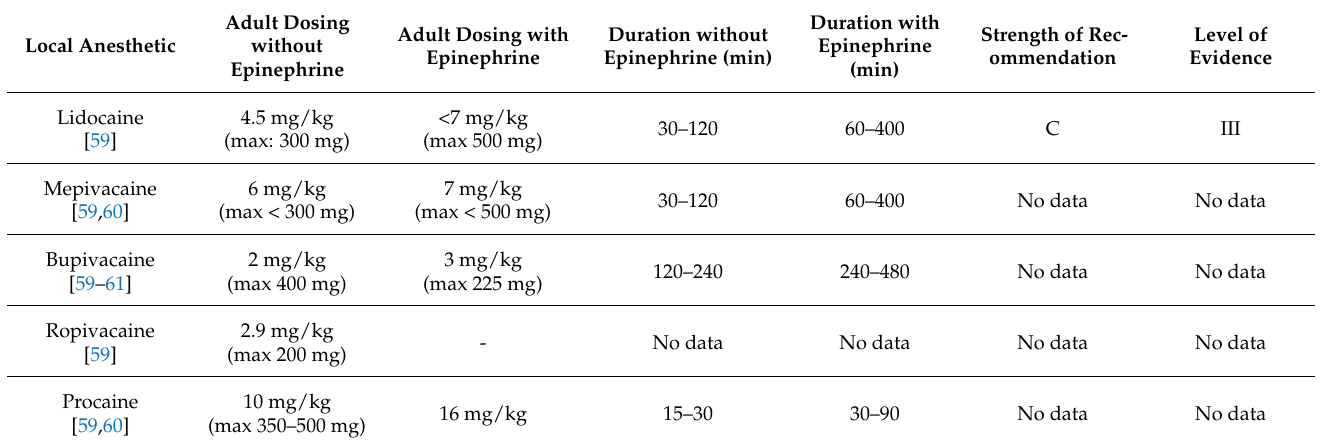
Table 1. Recommended local anesthetics doses for